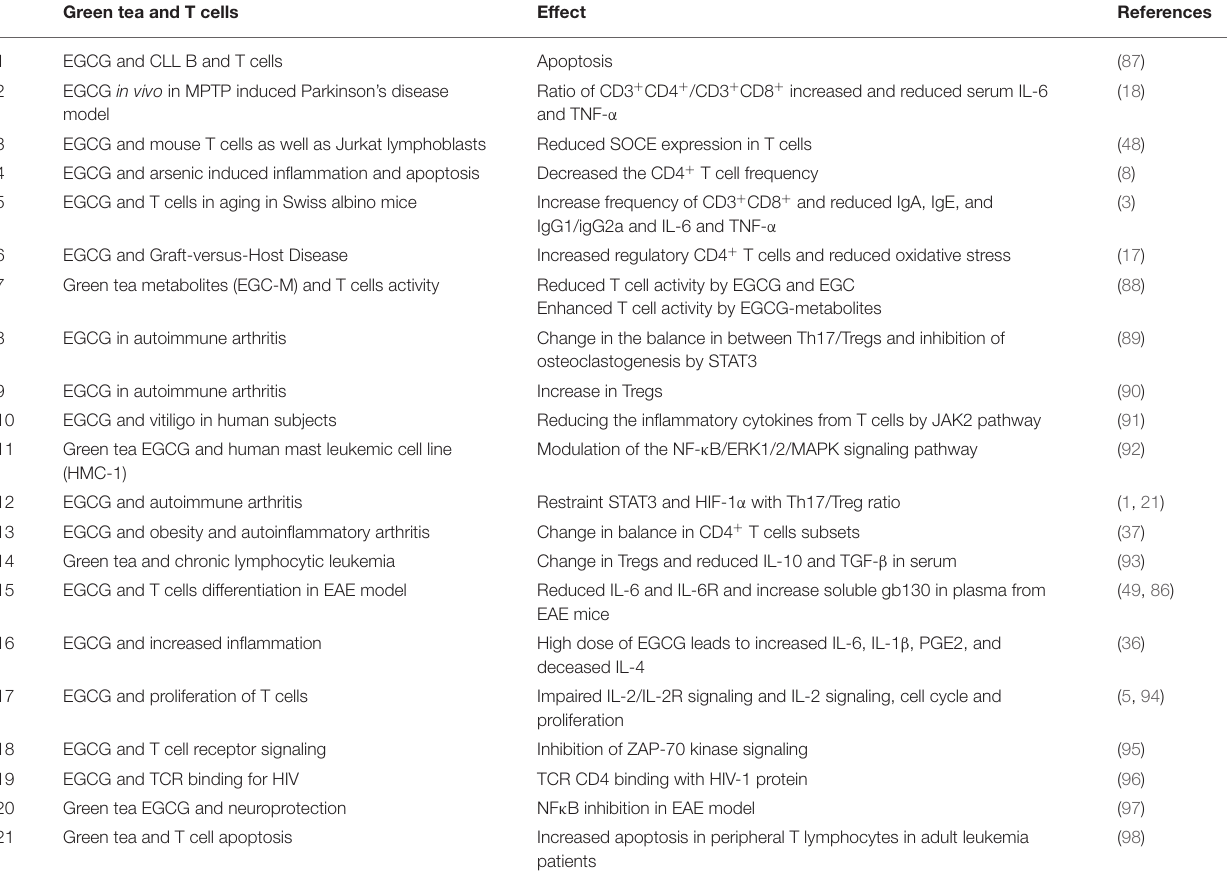
TABLE 1 | Effects of green tea polyphenol such as EGCG and its different components on immune T cells. Green tea and T